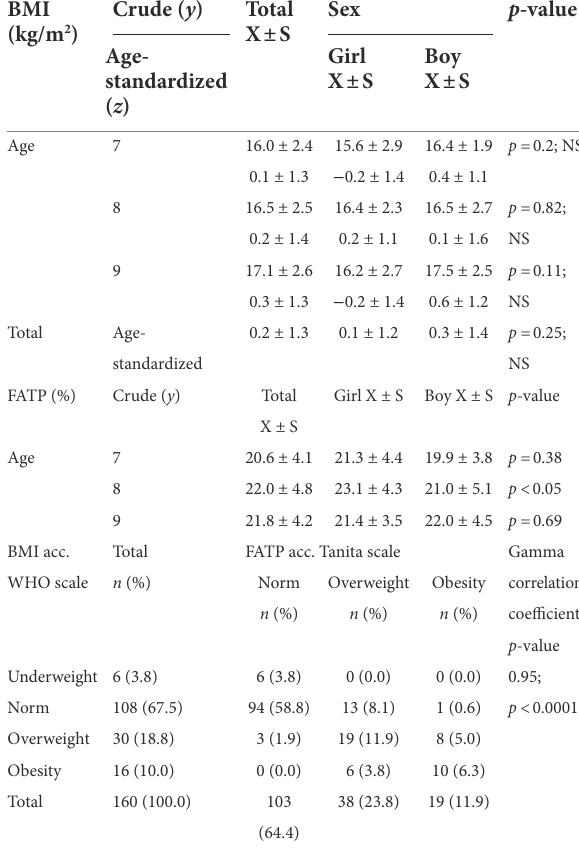
TABLE 2 Average values of the Body Mass Index (BMI) and the percentage of adipose tissue (FATP) in age groups, according to sex. Summary of body weight assessments according to BMI and FATP